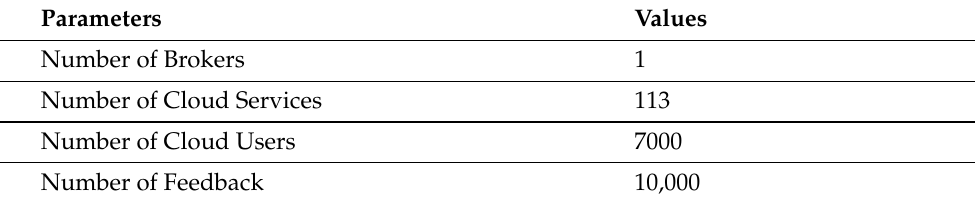
Table 4. Simulation